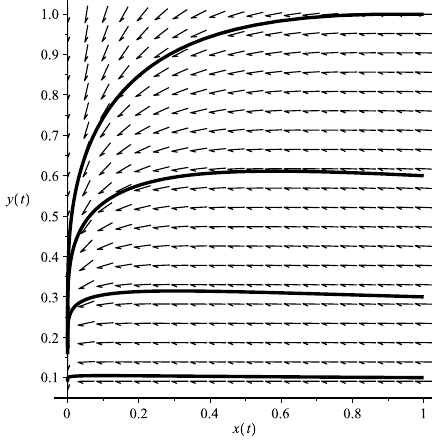
Figure 1: Dynamic behavior of system (5.1), here the initial condition ( x (0), y (0)) = (1, 1) , (1, 0.3), (1, 0.1) and (1, 0.6) ,